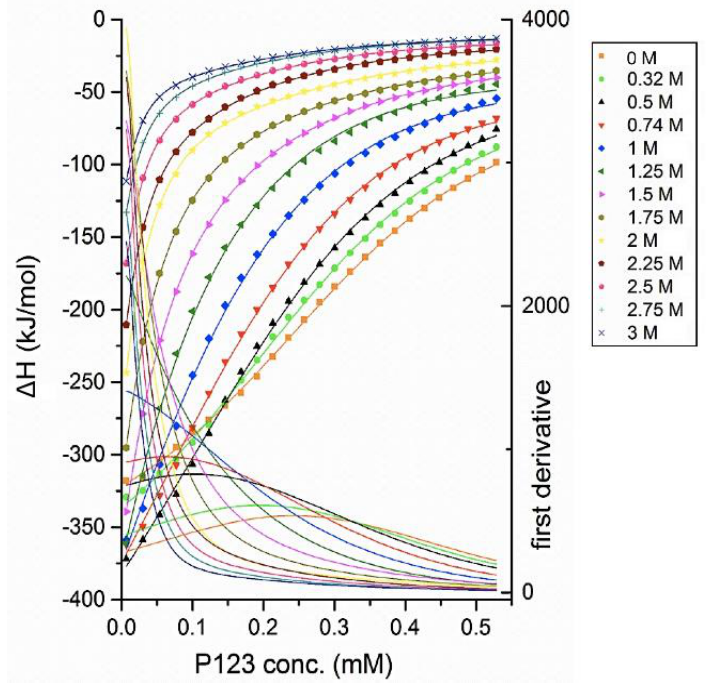
Figure 5. Enthalpy changes of titrating micellar 3.2 mM Pluronic P123 in EAN aqueous solution into aqueous solution with the same EAN content at 20 °C. The enthalpy change for each injection was obtained by ITC and then was standardized by dividing by the amount of the injected Pluronic for each injection. The maximum of the first derivative of the enthalpogram (solid lines) indicates the CMC. The EAN concentration at each titration is shown in the legend.